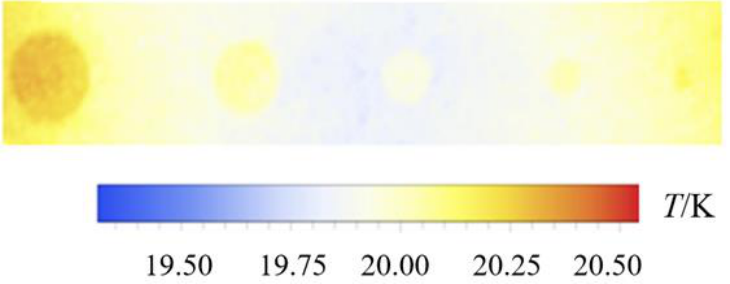
Figure 3. Thermal data captured by an infrared camera.